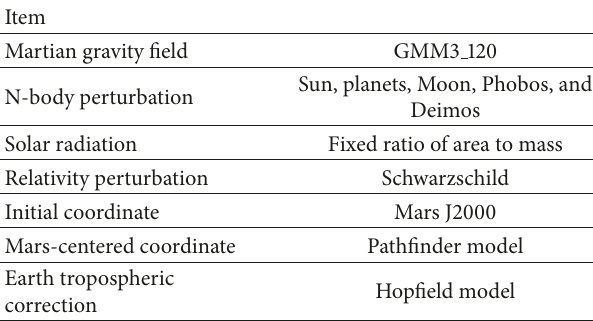
Table 2: The configuration of SODP in MEX